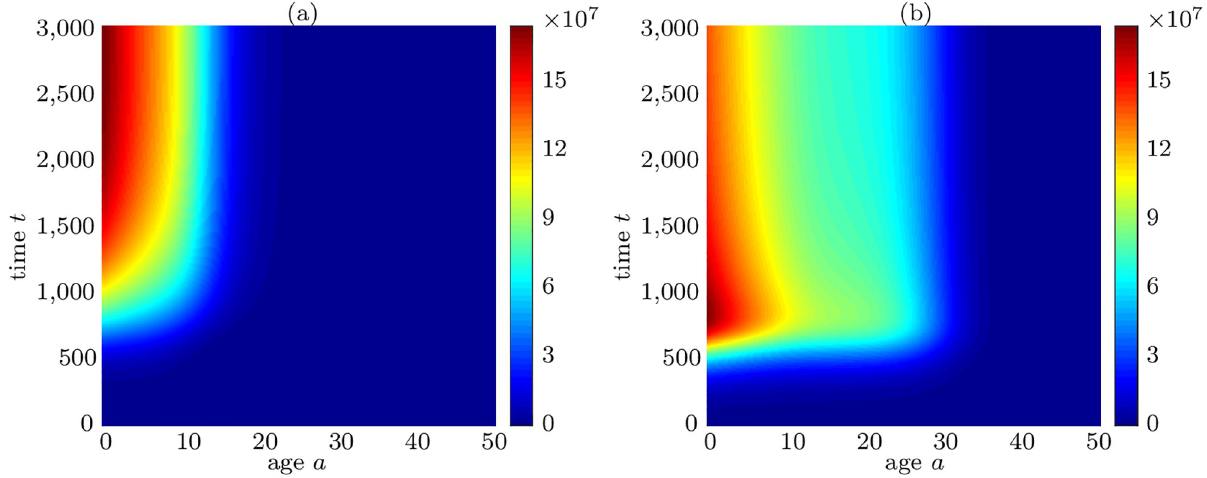
Fig 3. Cell number density distribution. (a) quiescent and (b) proliferating cell populations.